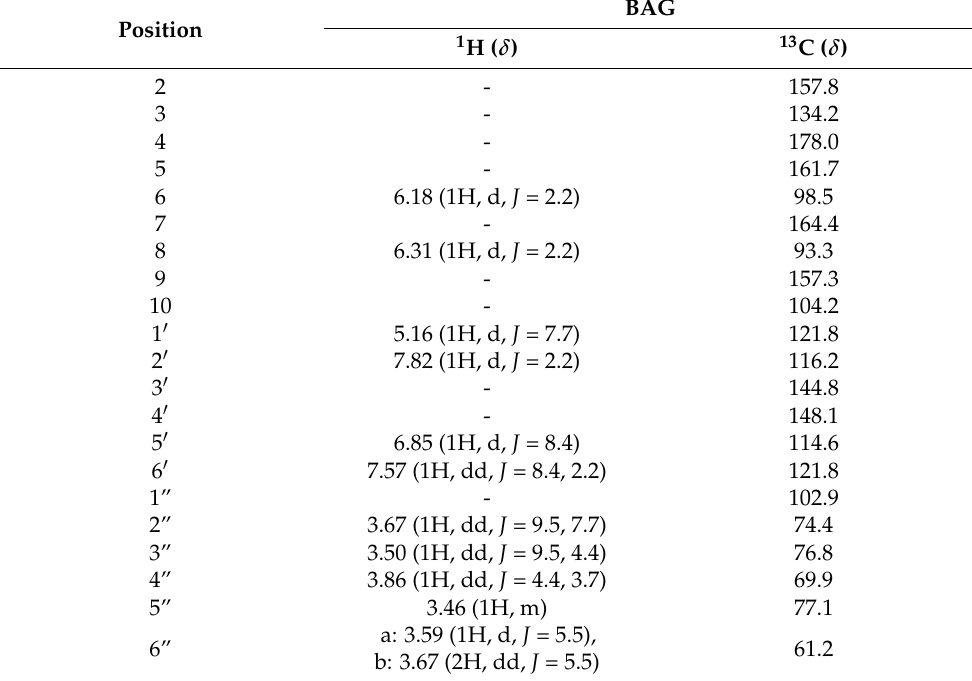
Table 1. 1 H (700 MHz) and 13 C (175 MHz) NMR data of BAG in CD 3